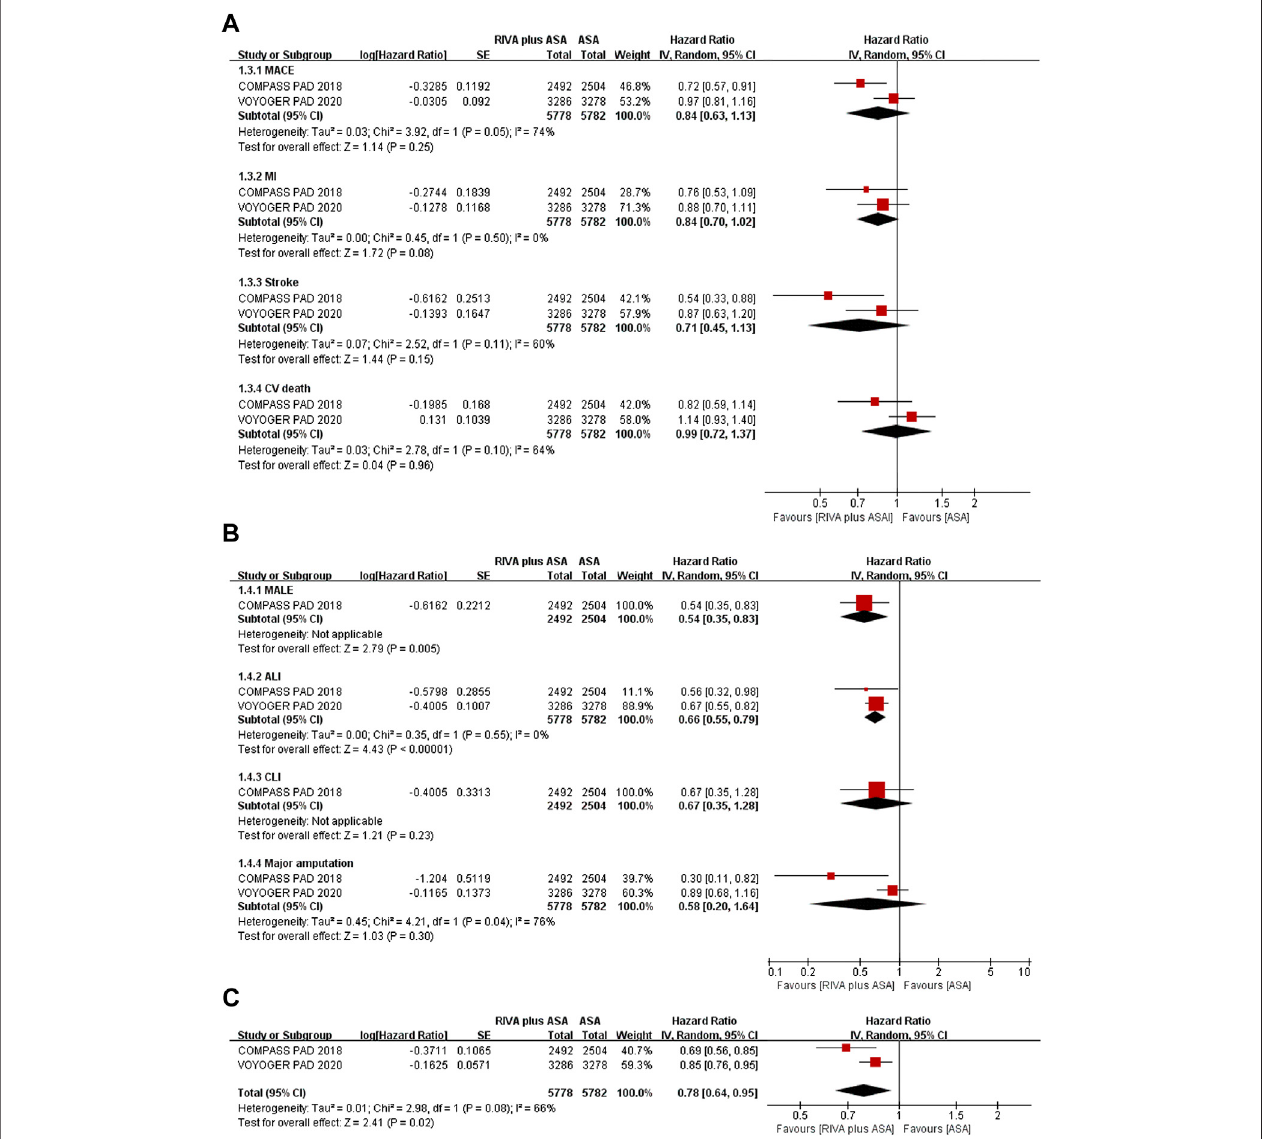
FIGURE4| (A) Forest plot oftherisk ofMACE (B) Forest plot ofthe riskofMALE (C) Forest plot oftherisk ofthecompositeofMACE or MALE in peripheral arterial disease patients treated with rivaroxaban plus aspirin and aspirin. MACE, major adverse cardiovascular event; MI, myocardial infarction; CV, Cardiovascular; MALE, major adverse limb event; ALI, acute limb ischemia; CLI, chronic limb ischemia; RIVA, rivaroxaban; ASA, aspirin; IV, inverse variance; VOYOGER PAD, Vascular Outcomes Study of ASA (acetylsalicylic acid) Along with Rivaroxaban in Endovascular or Surgical Limb Revascularization for peripheral artery disease; COMPASS PAD, peripheral arterial disease in the Cardiovascular Outcomes for People Using Anticoagulation Strategies